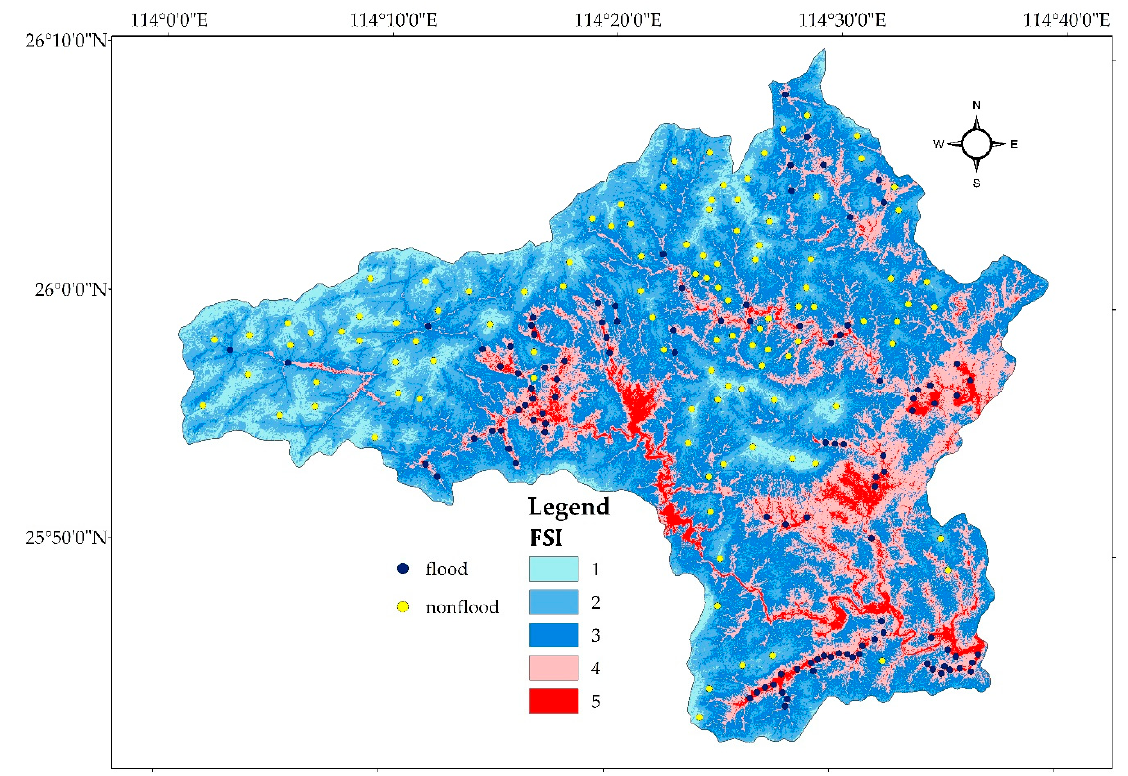
Figure 7. The final flood susceptibility map for the study area with historic flood locations. Table 8. Areas of the classes from the final flood susceptibility map.